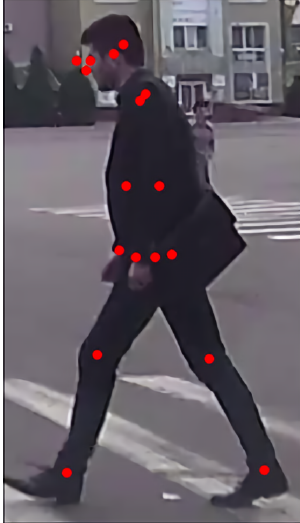
Figure 2. Cropped pedestrian example with pose (from